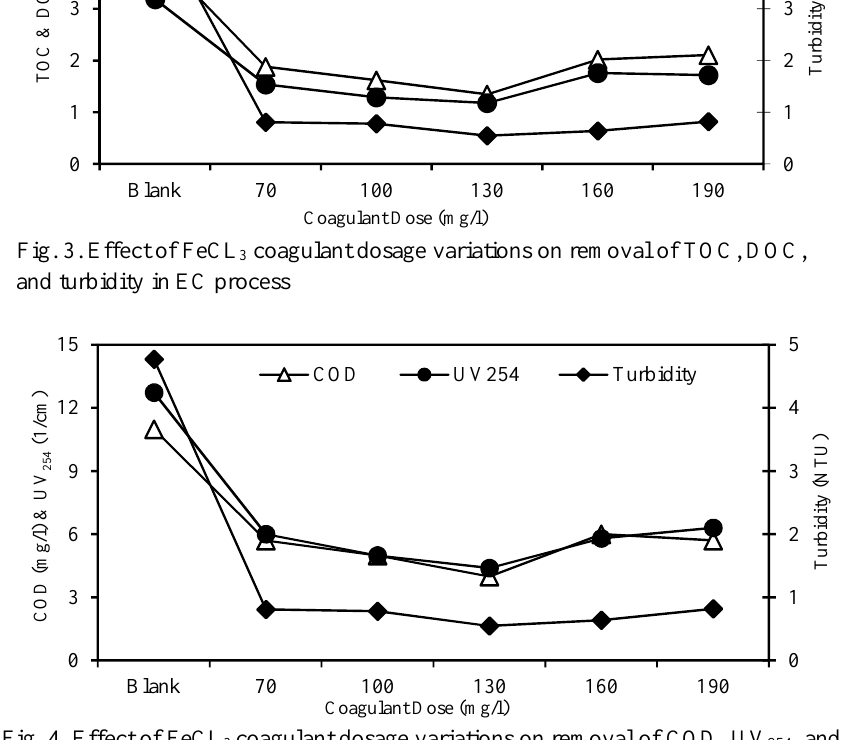
Fig. 4. Effect of FeCL 3 coagulant dosage variations on removal of COD, UV 254 , and turbidity in EC